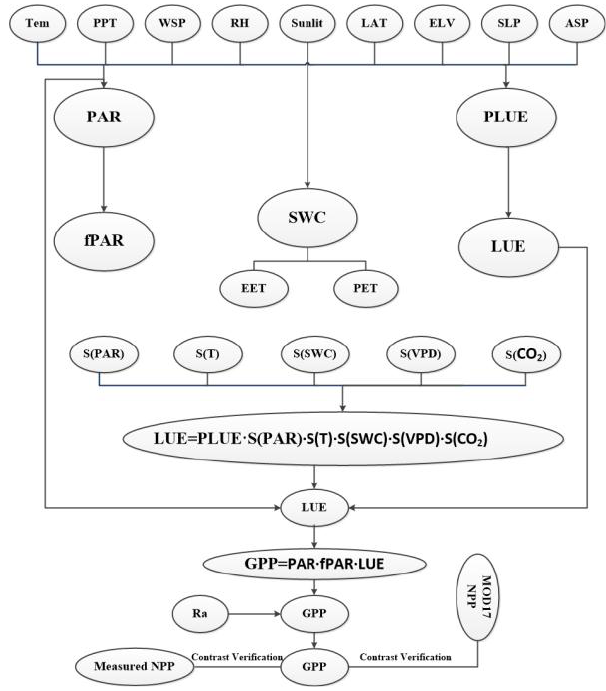
Figure 2. The framework of the GLOPEM-CEVSA model.